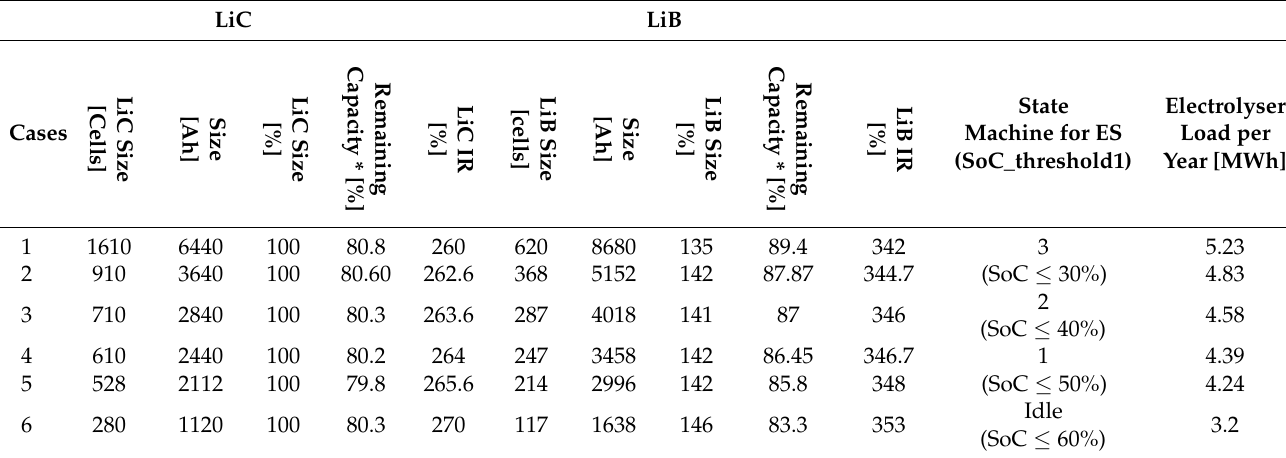
Table 2. Comparison between LiC and LiB ES for the green hydrogen production from PV (*refers to the remaining capacity after 10 years of operation). LiB